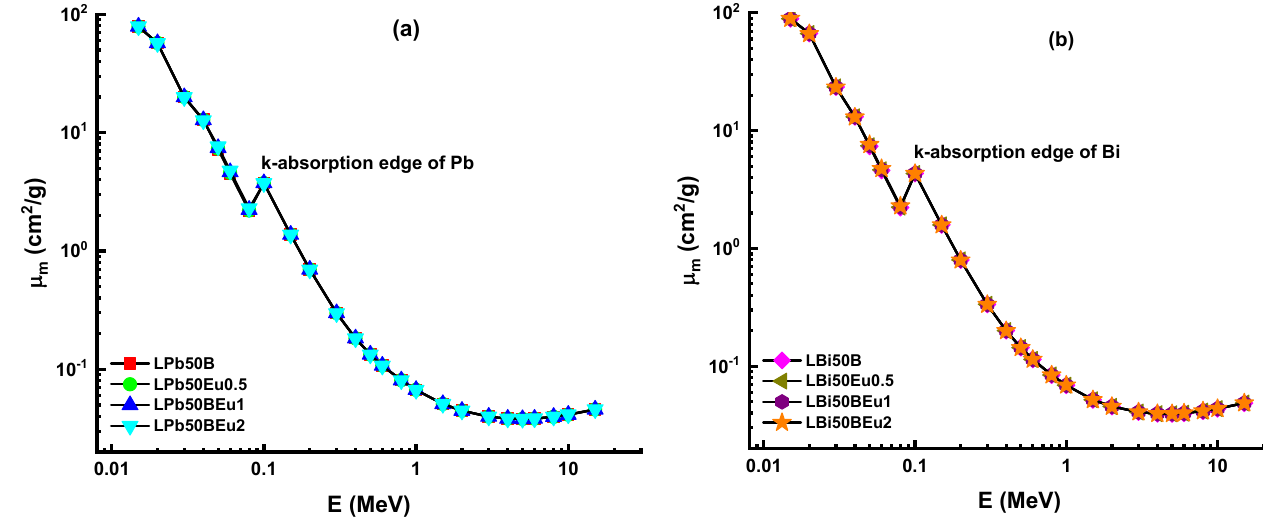
Figure 3. Variation of mass attenuation coefficient ( µ m ) against photon energy for ( a ) LPb50BEu and ( b ) LBi50BEu glasses.